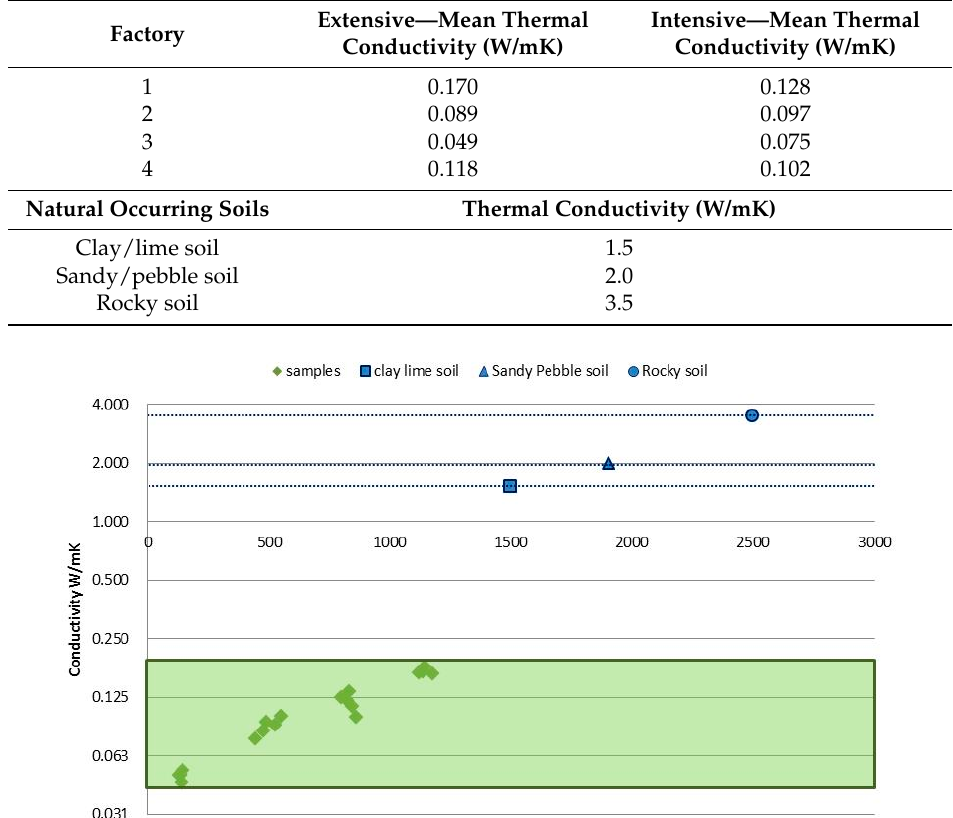
Table 4. Dry thermal conductivity—natural occurring soils [61] and growing media. Factory